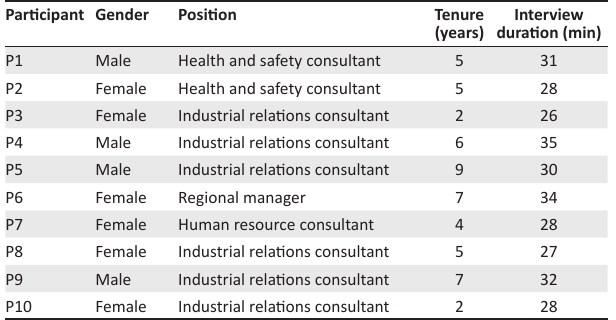
TABLE 1: Description of the participants’ profiles. TABLE 2: Main